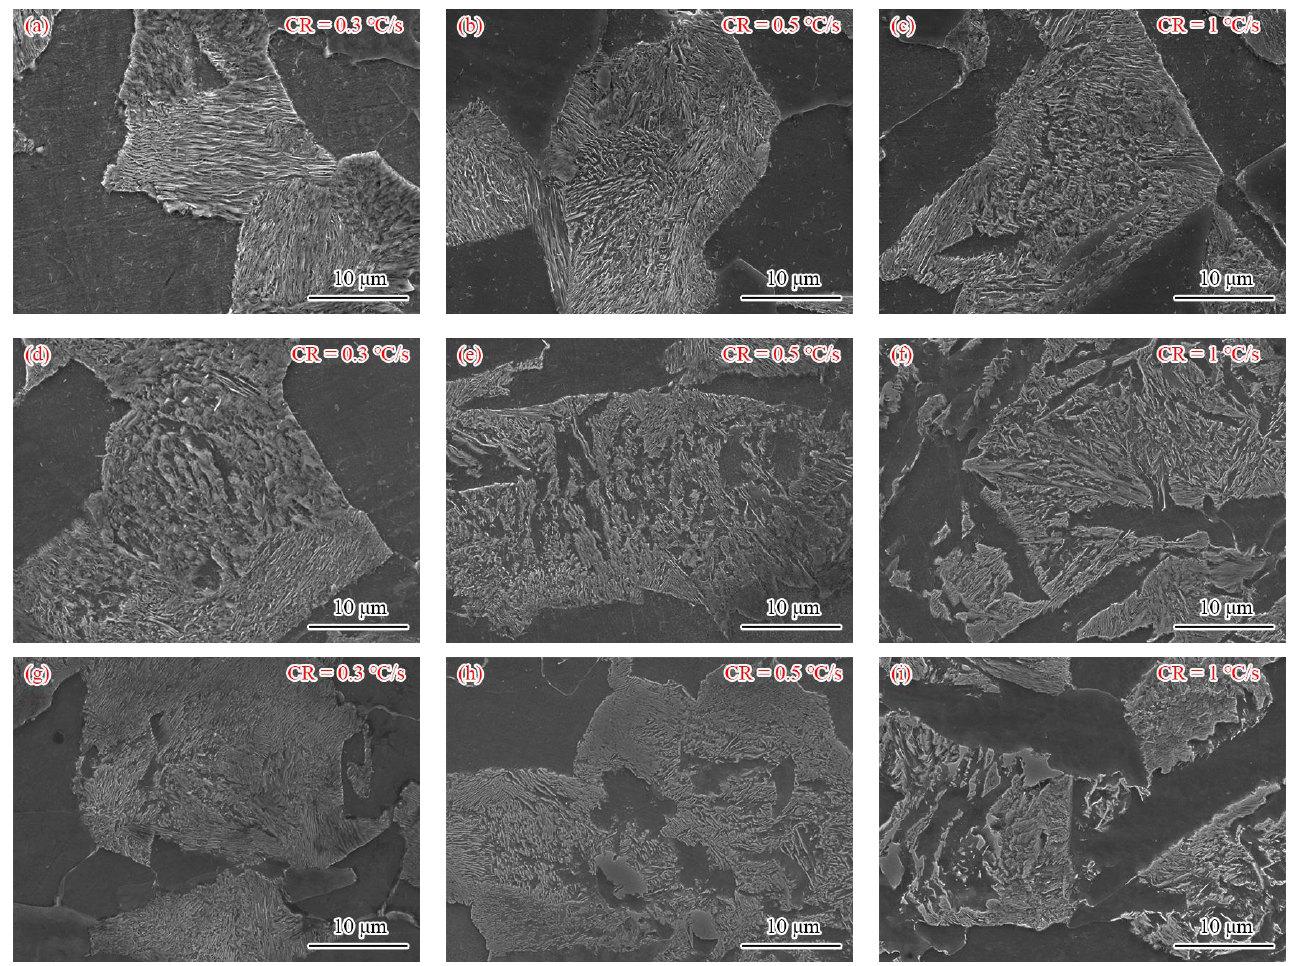
Figure 9. SEM morphologies of continuously-cooled specimens. ( a – c ) Nb-1, ( d – f ) Nb-2 and ( g – i ) Nb-3.